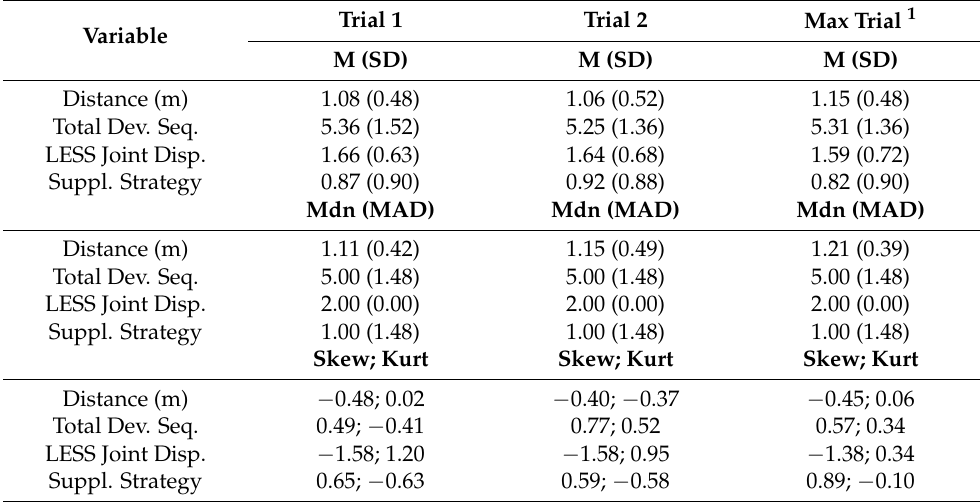
Table 1. Descriptive statistics for individual SLJ trials and the isolated (max) trial, which was composed of scores from the trial with the longest SLJ